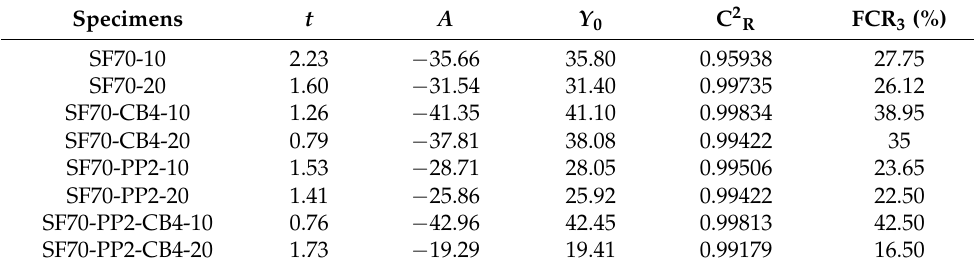
Figure 7. Relationship between FCR and COD of ( a ) SF70-20 ( b ) SF70-CB4-20 ( c ) SF70-PP2-20 ( d ) SF70-PP2-CB4-20. Table 5. Fitted parameters through exp decay fit